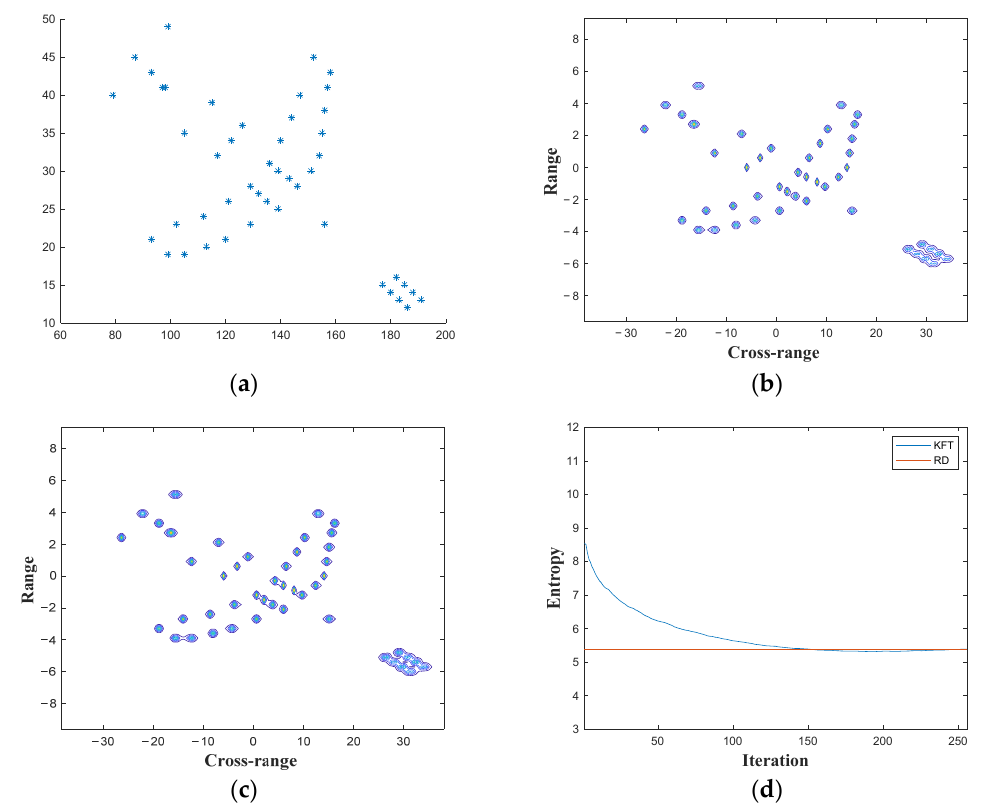
Figure 5. Simulation results. ( a ) The 2D scatter model of the plane target. ( b ) Image of the plane target using the RD method.